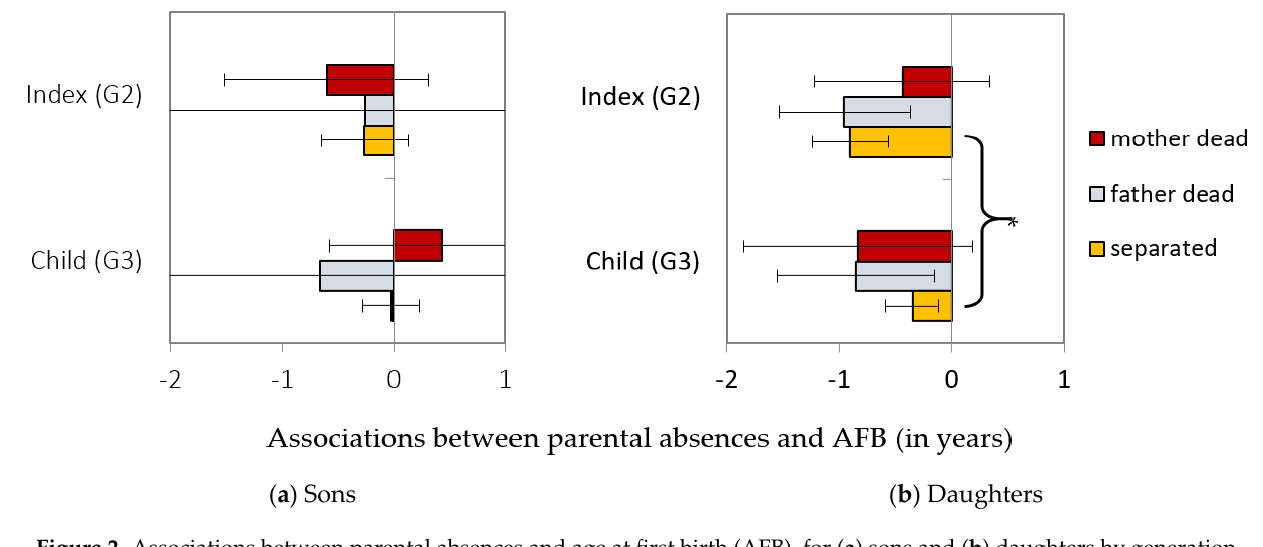
Figure 2. Associations between parental absences and age at first birth (AFB), for ( a ) sons and ( b ) daughters by generation. All associations are shown relative to having married and cohabiting parents and are derived from separate models for each cohort and sex. Tests for differences between cohorts are derived from models with interactions between parental absences and cohort. Robust 95% CIs are shown. * p < 0.05. Table 2. Linear regression models predicting age at first birth from parental presence within first 20 years of life. Robust standard errors controlling for family clusters (parent’s id) are given.